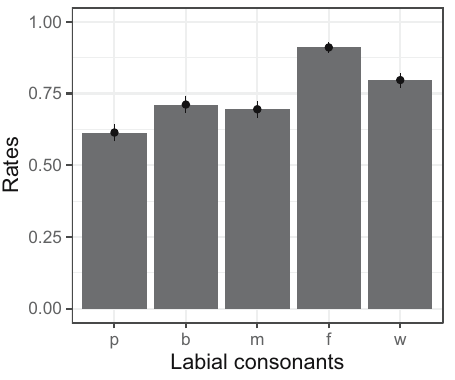
Figure 1: Rates of selecting names with labial consonants for a “ soft ” name ( Japanese ) .